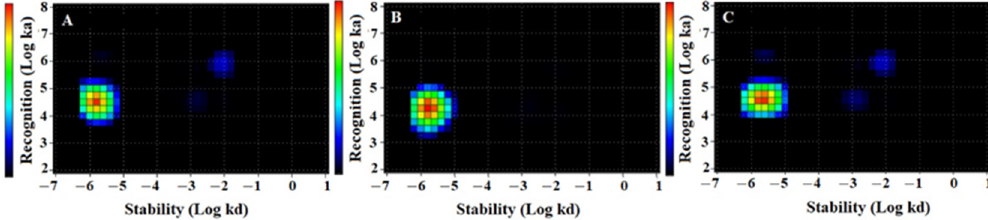
Figure 4. In vitro binding specificity of ( A , D ) [ 99m Tc]Tc-ZHER2:41071, ( B , E ) [ 99m Tc]Tc-ZHER2:V2 and ( C , F ) [ 99m Tc]Tc-ZHER2:2395 to HER2-expressing SKOV3 ( A – C ) and BT-474 ( D – F ) cell-lines. For the pre-saturation of HER2, a 500-fold molar excess of a non-radioactive affibody molecule was added. The data are presented as an average value from three samples ± SD.